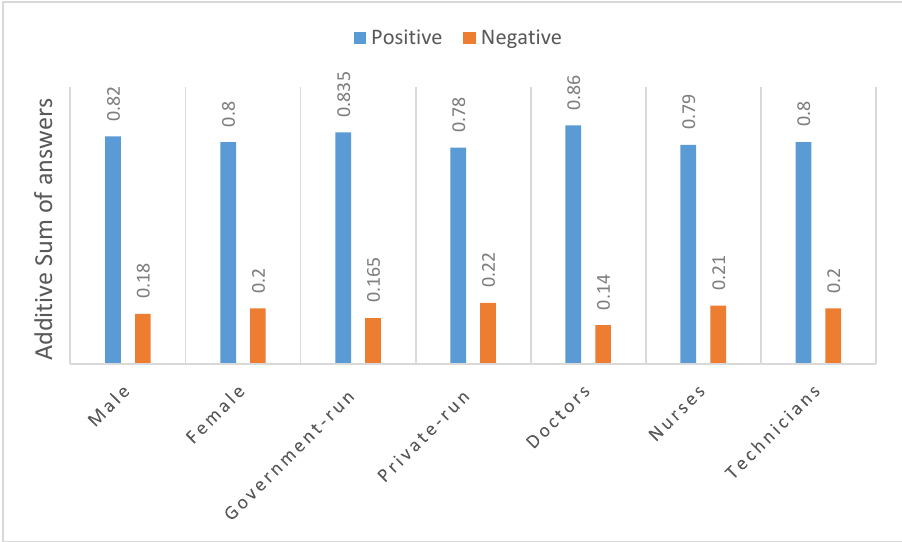
Fig. 2: Module 1 additive sums of positive answers (blue) and negative answers (orange)